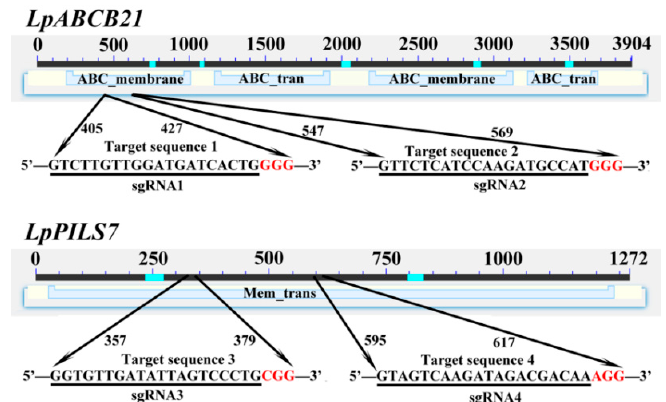
Figure 2. Selection of sgRNA for LpABCB21 and LpPILS7 gene editing. The conserved domains and their locations are labeled. The cyan lines correspond to compositionally biased regions and were not used for domain database search. The red letters correspond to the NGG domains.